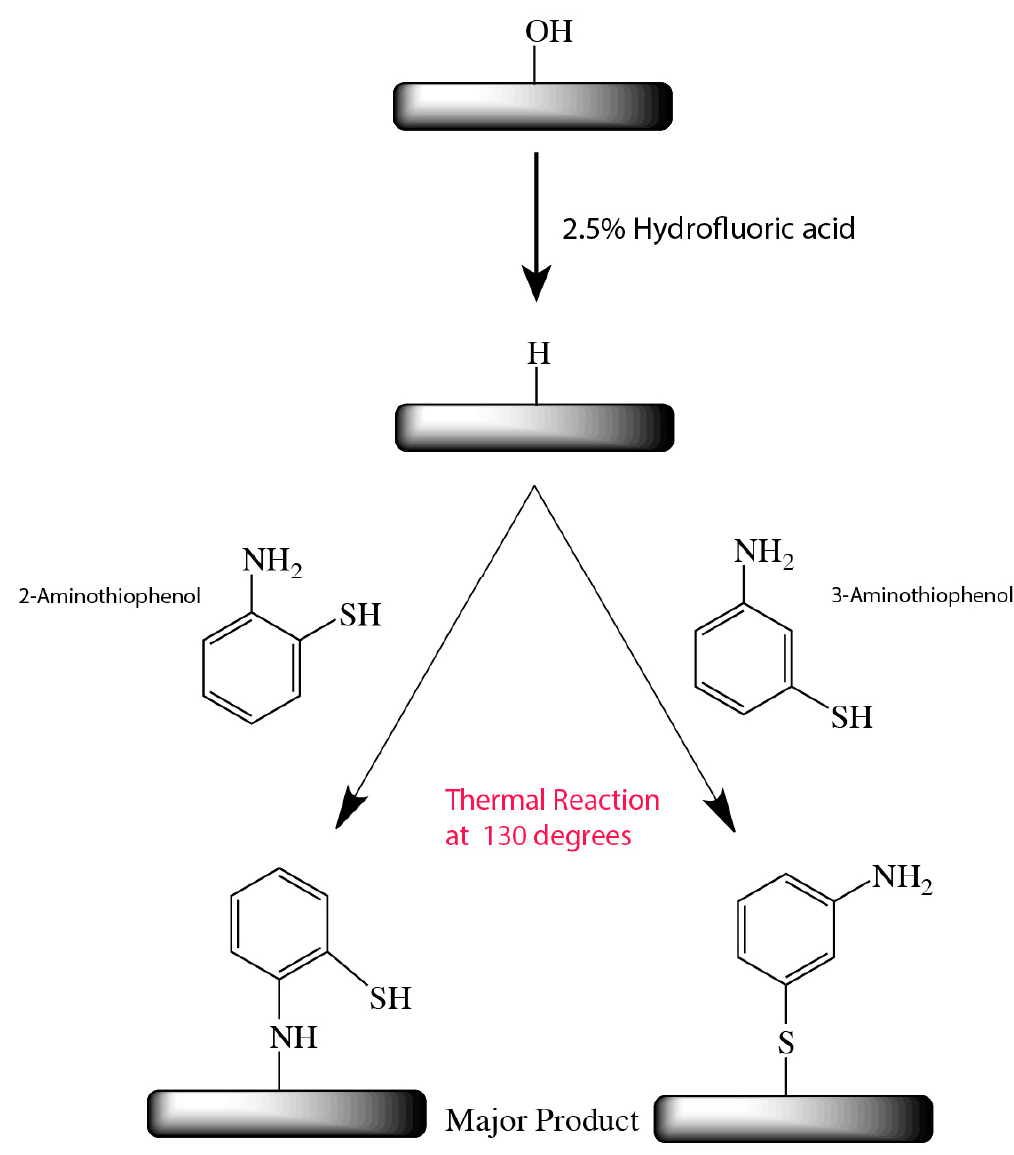
Figure 6. Reaction outcome for thermal grafting of 2-aminothiophenol and 3-aminothiophenol on silicon (111) hydride